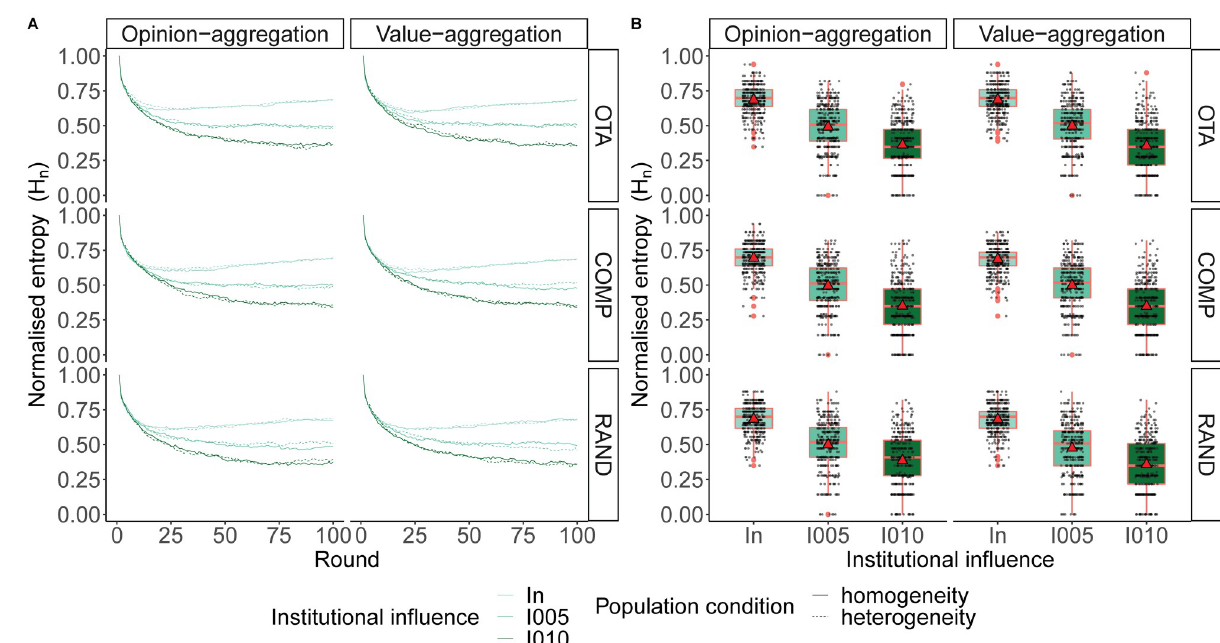
Fig 5. A. Opinion diversity (measured as normalised Shannon Entropy) for I ( ε = 0), I 005 ( ε = 0.05) and I 010 ( ε = 0.1), under opinion-aggregating and n value-aggregating institutions, averaged over each level of population homogeneity and initial value system when opinion value bias ( β = 0.5). B. Standard box plot of opinions diversity at round 100 for I ( ε = 0), I 005 ( ε = 0.05) and I 010 ( ε = 0.1), under opinion-aggregating and value-aggregating n institutions, averaged over each initial value system. Red line indicates median, red triangle indicates mean. Each black dot represents the final entropy of a simulation in that